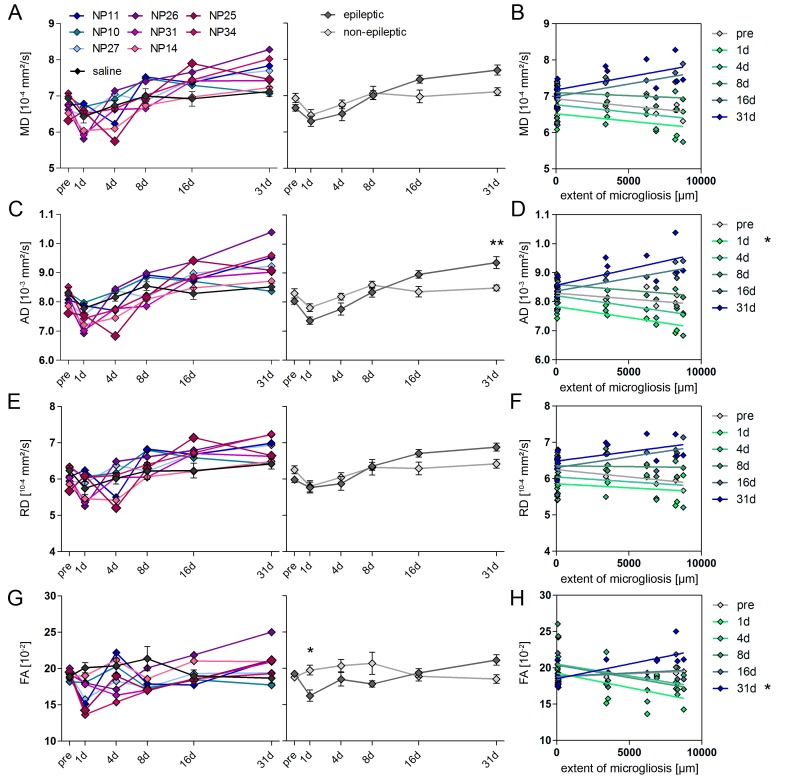
DWI changes in CA1 during epileptogenesis are poor predictors for hippocampal sclerosis.(A, C, E, G) Quantitative analysis of DWI metrics in the CA1 region, plotted for individual mice (left panel; controls, black, n = 5; kainate-injected animals color-coded) and groups (right panel; epileptic, dark grey; non-epileptic, light grey) during epileptogenesis. Two-way ANOVA, Bonferroni’s post-test, *p<0.05; **p<0.01; nnon-epi = 6, nepi = 7. Values are presented as the mean ± SEM. (B, D, F, H) Corresponding linear regression analysis of DWI metrics at distinct time points during epileptogenesis with the extent of microglial scarring in the CA1 region of epileptic and non-epileptic mice (n = 13; Pearson’s correlation, corrected for multiple comparison; *p<0.05).